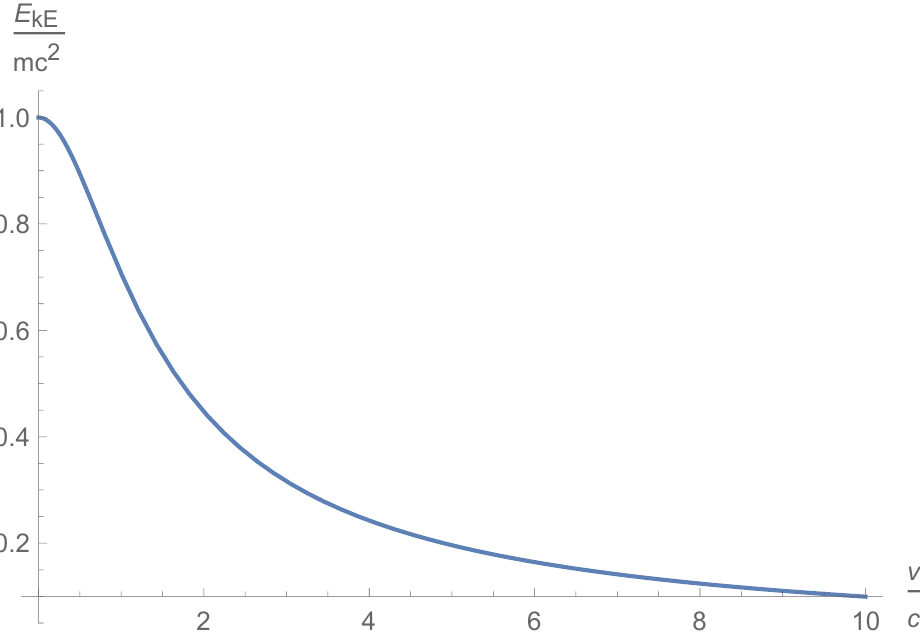
Figure 8. Kinetic energy for Euclidean particles of subluminal and superluminal